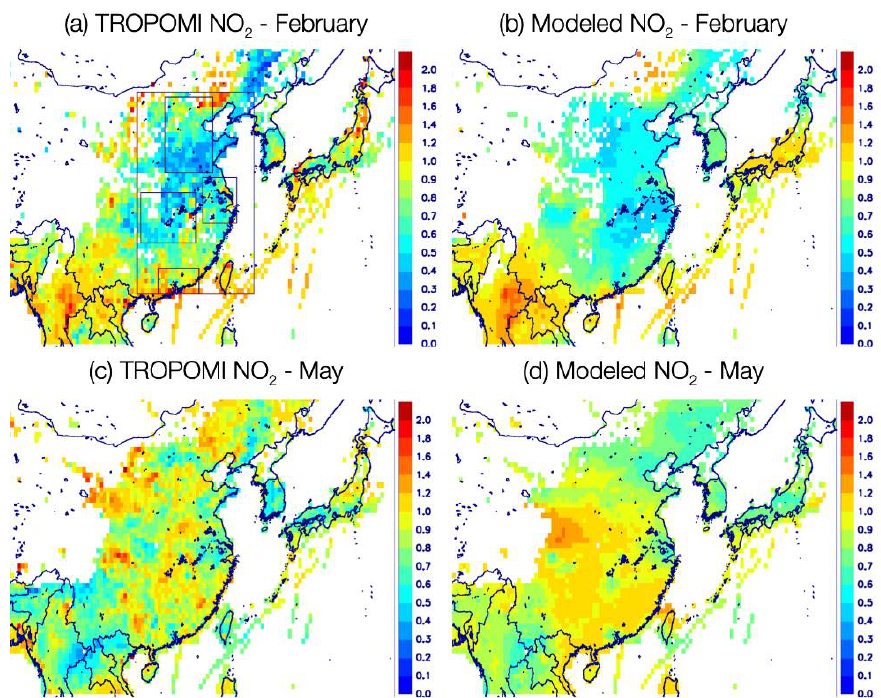
Figure 3. ( a , b ) NO 2 column ratio, February 2020 divided by February 2019, according to TROPOMI (left) and to the R1 simulation (right). ( c , d ) Idem for May. Invalid data and areas with very low total NO x emissions (less than 2 × 10 10 molec.cm −2 s −1 ) are left blank. The boxes of panel ( a ) indicate the analysis regions (also shown in Figure 4).